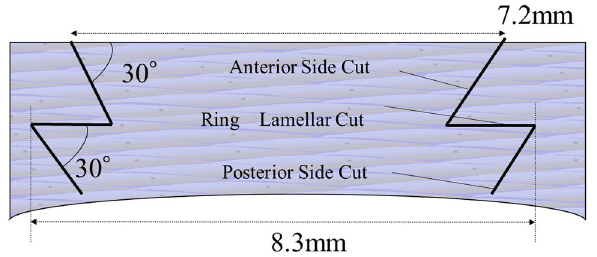
Figure 1. Cross-sectional diagram of the zig-zag penetrating keratoplasty (z-PK) procedure using a femtosecond